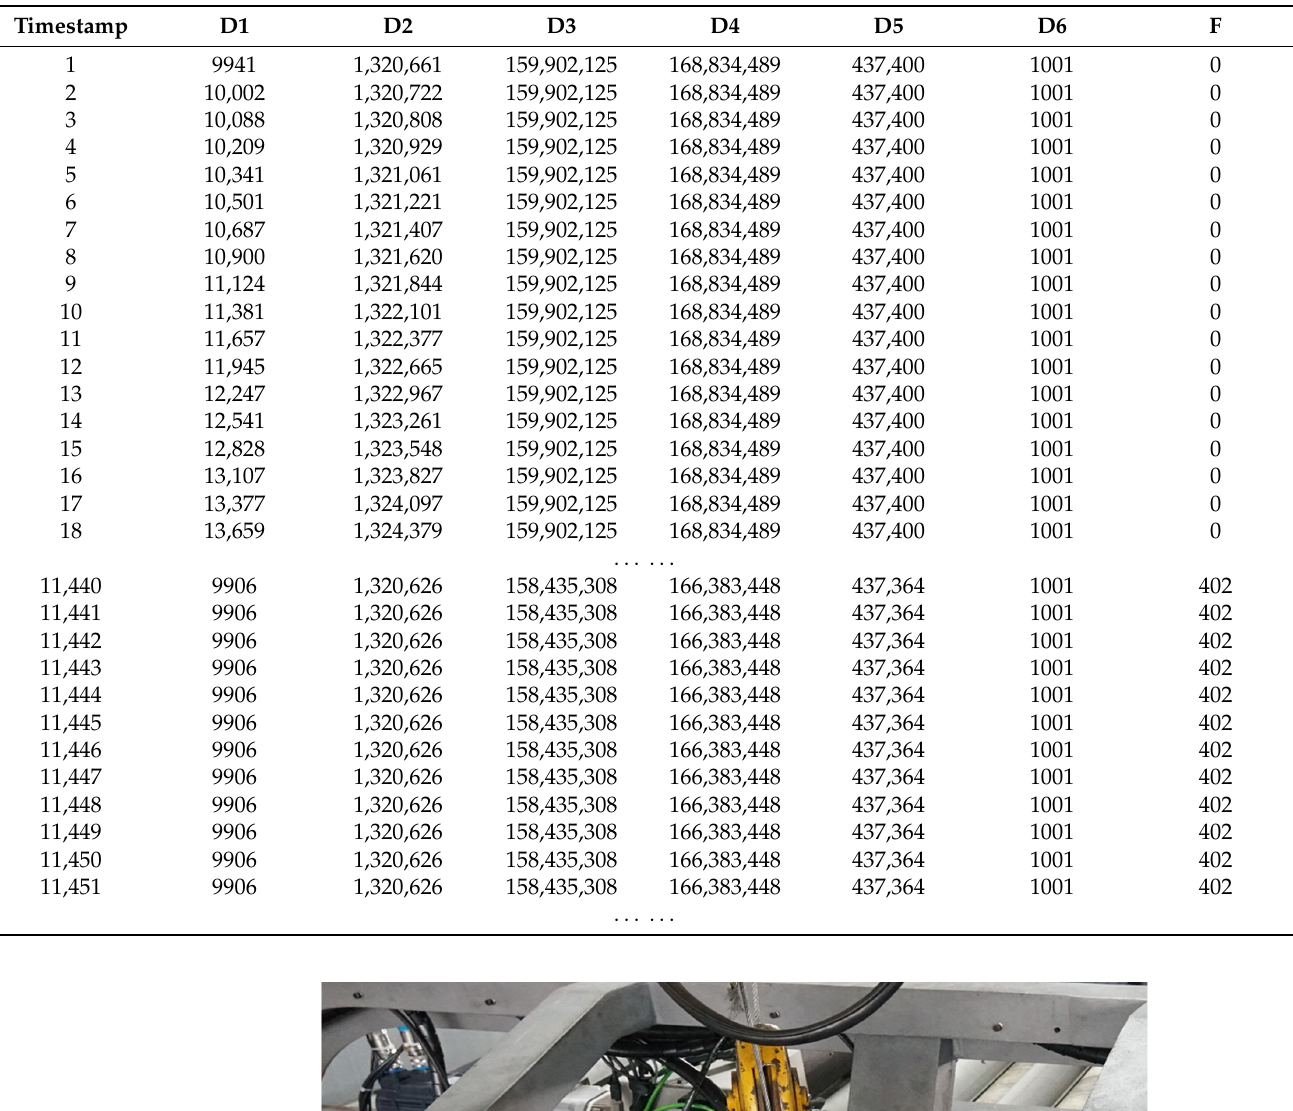
Table 1. The structure of the experimental data.